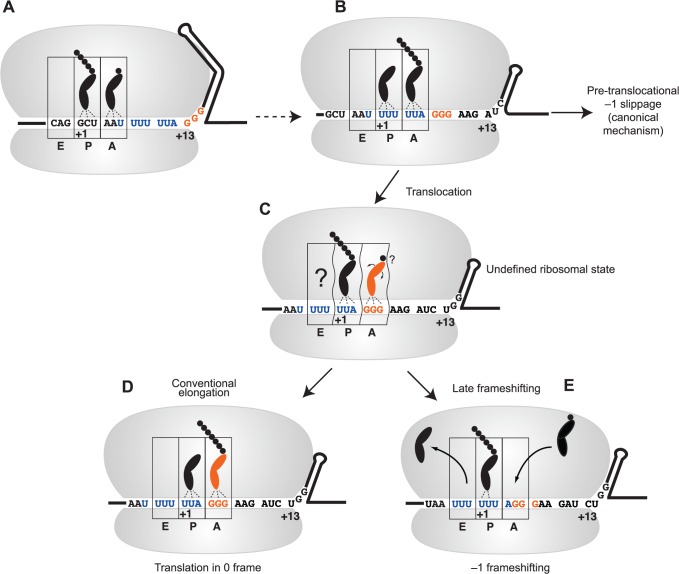
A modified model for −1 frameshifting in HIV-1.A. The first nucleotide (U) of the slippery sequence (blue), as part of the ‘BCX’ codon [26], is positioned in the A site. The extended stem-loop is at the entrance to the ribosome, with the first nucleotide of the intercodon (orange) in the +13 position. B. The lower stem of the structure unwinds and allows the slippery sequence into the decoding centre. The stable upper stem-loop is positioned near the entry channel of the ribosome. Tension arising from resistance to unwinding may allow slippage from the A and P sites at this stage. C. After partial unwinding of the stable upper stem-loop, binding of tRNAGly to the intercodon, perhaps in a distorted state, competes with −1 frameshifting. D. The tRNAGly bound to the intercodon is decoded and translation proceeds in the 0 frame. This is the most common event, resulting in the translation of the Gag product. E. If the tRNAGly is not decoded, −1 frameshifting by the E and P site tRNAs occurs to relieve tension on the mRNA, resulting in the translation of Gag-Pol. An incoming tRNAArg is shown.